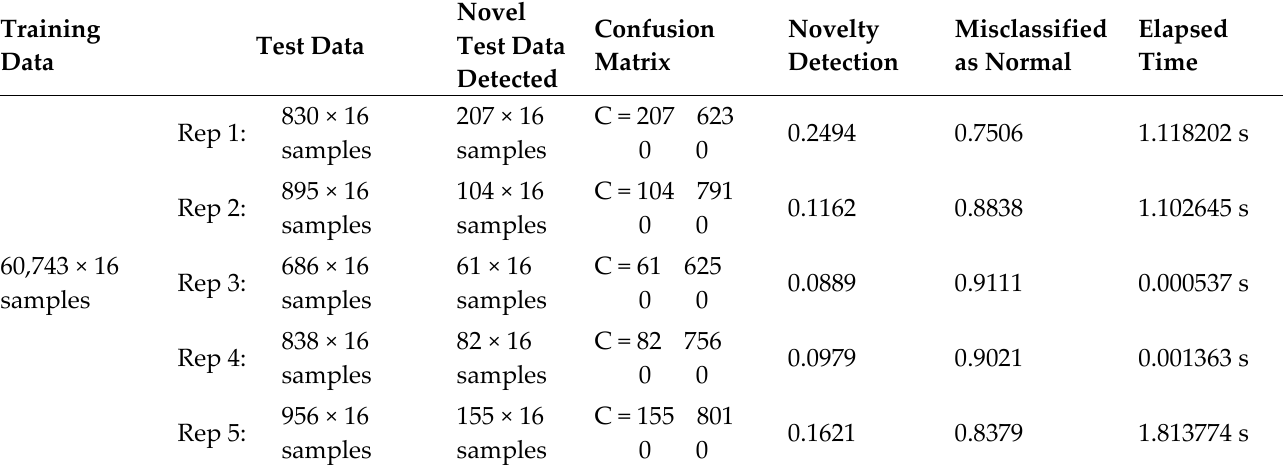
Table 4. OCSVM algorithm .